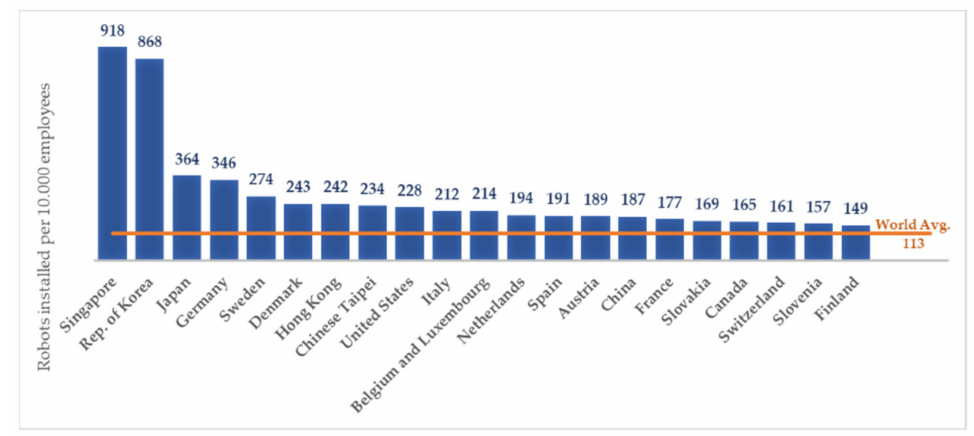
Figure 1. Worldwide manufacturing industry-related robot density in 2020. Source: Author’s contribution, based on International Federation of Robotics, https://ifr.org/news/robot-race-the- worlds-top-10-automated-countries/, accessed on 12 January 2022.